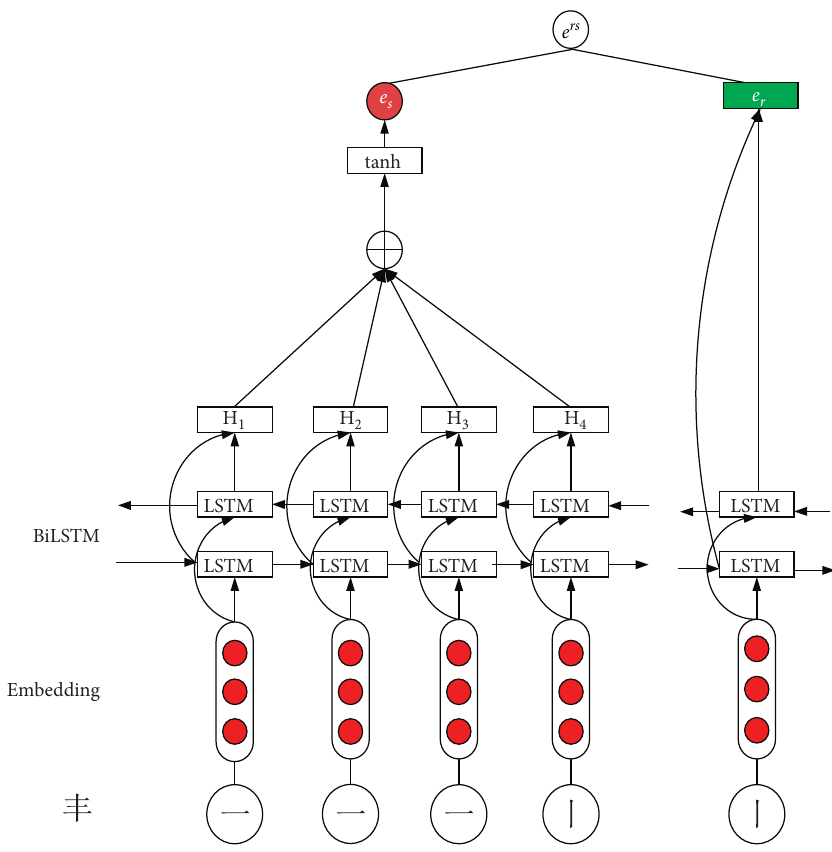
Figure 4: Stroke and radical feature calculation and fusion.